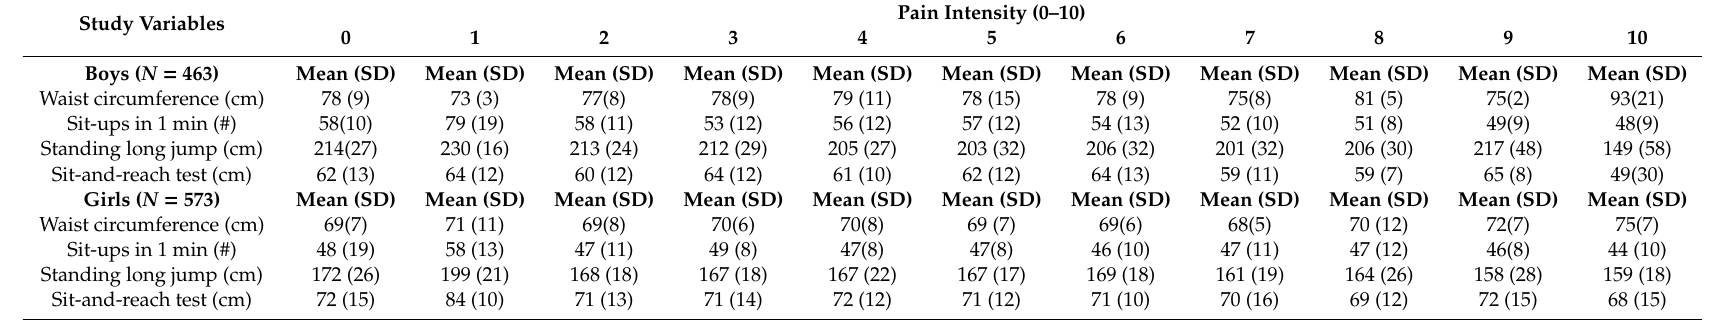
Table 1. Basic descriptive statistics of the study participants, Croatia (2019).